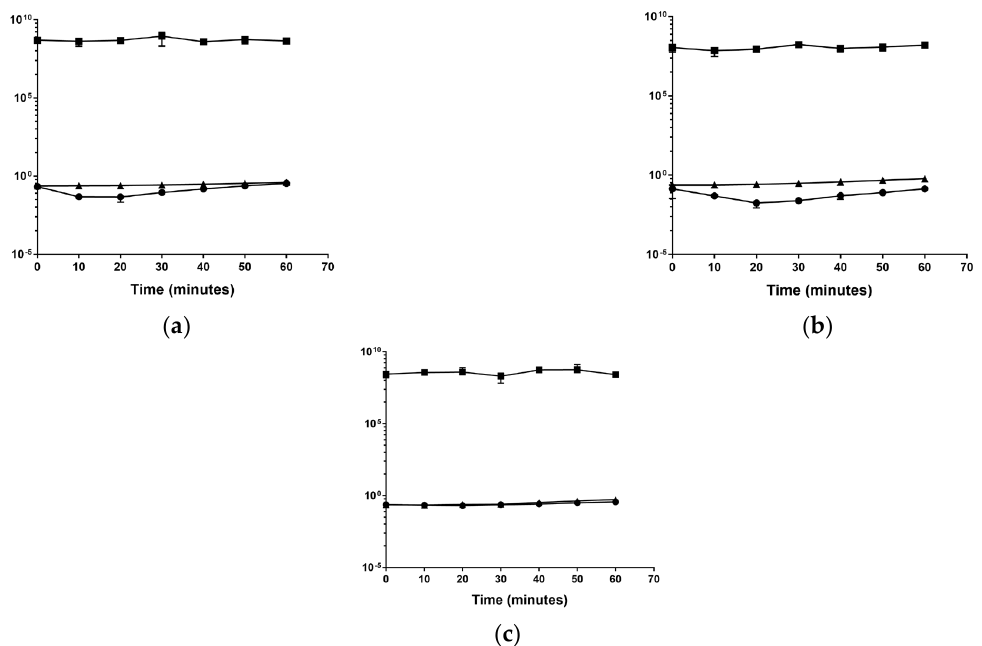
Figure 4. Comparison of changes in absorbance readings ( • ) and CFU/mL values for Serratia sp. HRI ( ■ ) as well as CFU/mL values of Serratia marcescens ATCC 13800 ( ▲ ) over 60 min cultivated in the presence of sub-MIC levels of disinfectants: ( a ) Benzalkonium chloride; ( b ) DDAC; ( c ) Virukill.